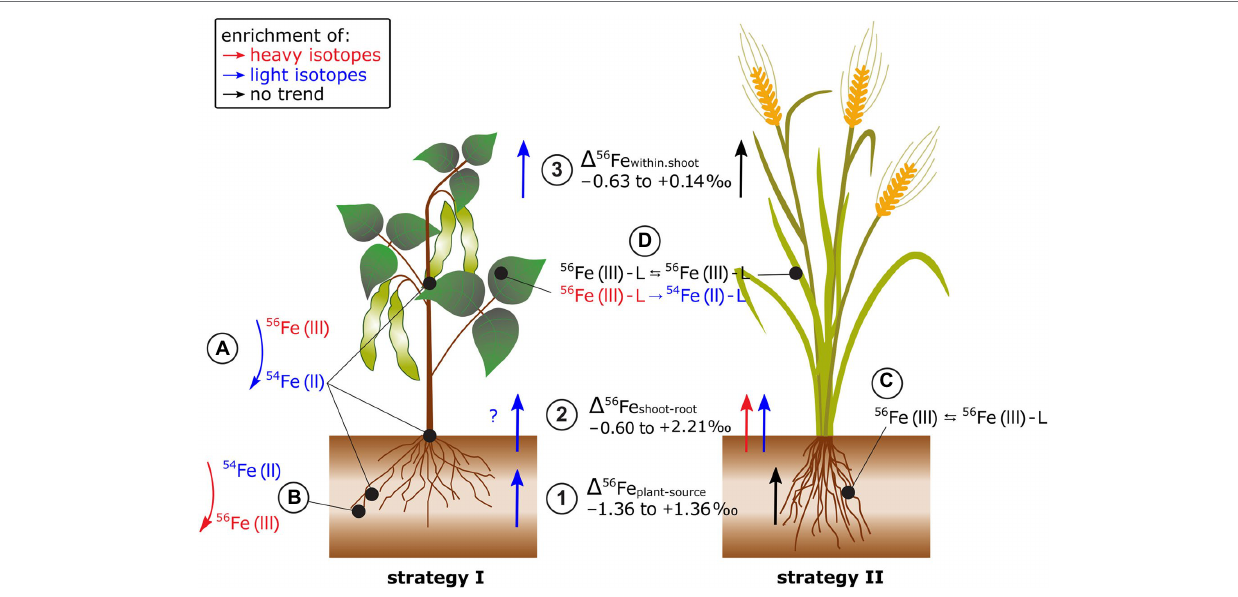
FIGURE 6 | Fe isotope fractionation in plants for Fe acquisition strategy I and II plants. (1) Fe isotope fractionation between the Fe source and the plant strongly depends on the Fe source (i.e., Fe-EDTA in hydroponics, bulk soil, or soil extract). In most cases, Fe acquisition by plants leads to a stronger enrichment of light isotopes in strategy I plants (e.g., tomato and beans) compared to strategy II plants. (2) The Fe isotope fractionation between shoot and root highly depends on the root Fe pools analyzed since significant fractionation can occur between precipitated Fe in the root apoplast compared to Fe that is taken up into the symplast and not deposited in the root apoplast. (3) Reproductive organs tend to be enriched in light isotopes in strategy I plants while no such fractionation step occurs in strategy II plants. (A) The Fe reduction from Fe(III) to Fe(II) prior to membrane transport may explain the successive enrichment of light isotopes from soil via roots and leaves to reproductive organs in strategy I plants. (B) Fe reoxidation from soluble Fe(II) to insoluble Fe(III) in the root apoplast can lead to an enrichment of light Fe isotope in the soluble Fe fraction. (C) In strategy II plants, the mobilization of Fe(III) from the mineral lattice of the soil by phytosiderophores (L for ligand, e.g., deoxymugineic acid) does not require a Fe reduction step and leads, if at all, to small Fe isotope fractionation. (D) Within the shoot, ligand (L) exchange of Fe (e.g., nicotianamine, citrate, and ferritin) that can include Fe redox changes may further fractionate Fe